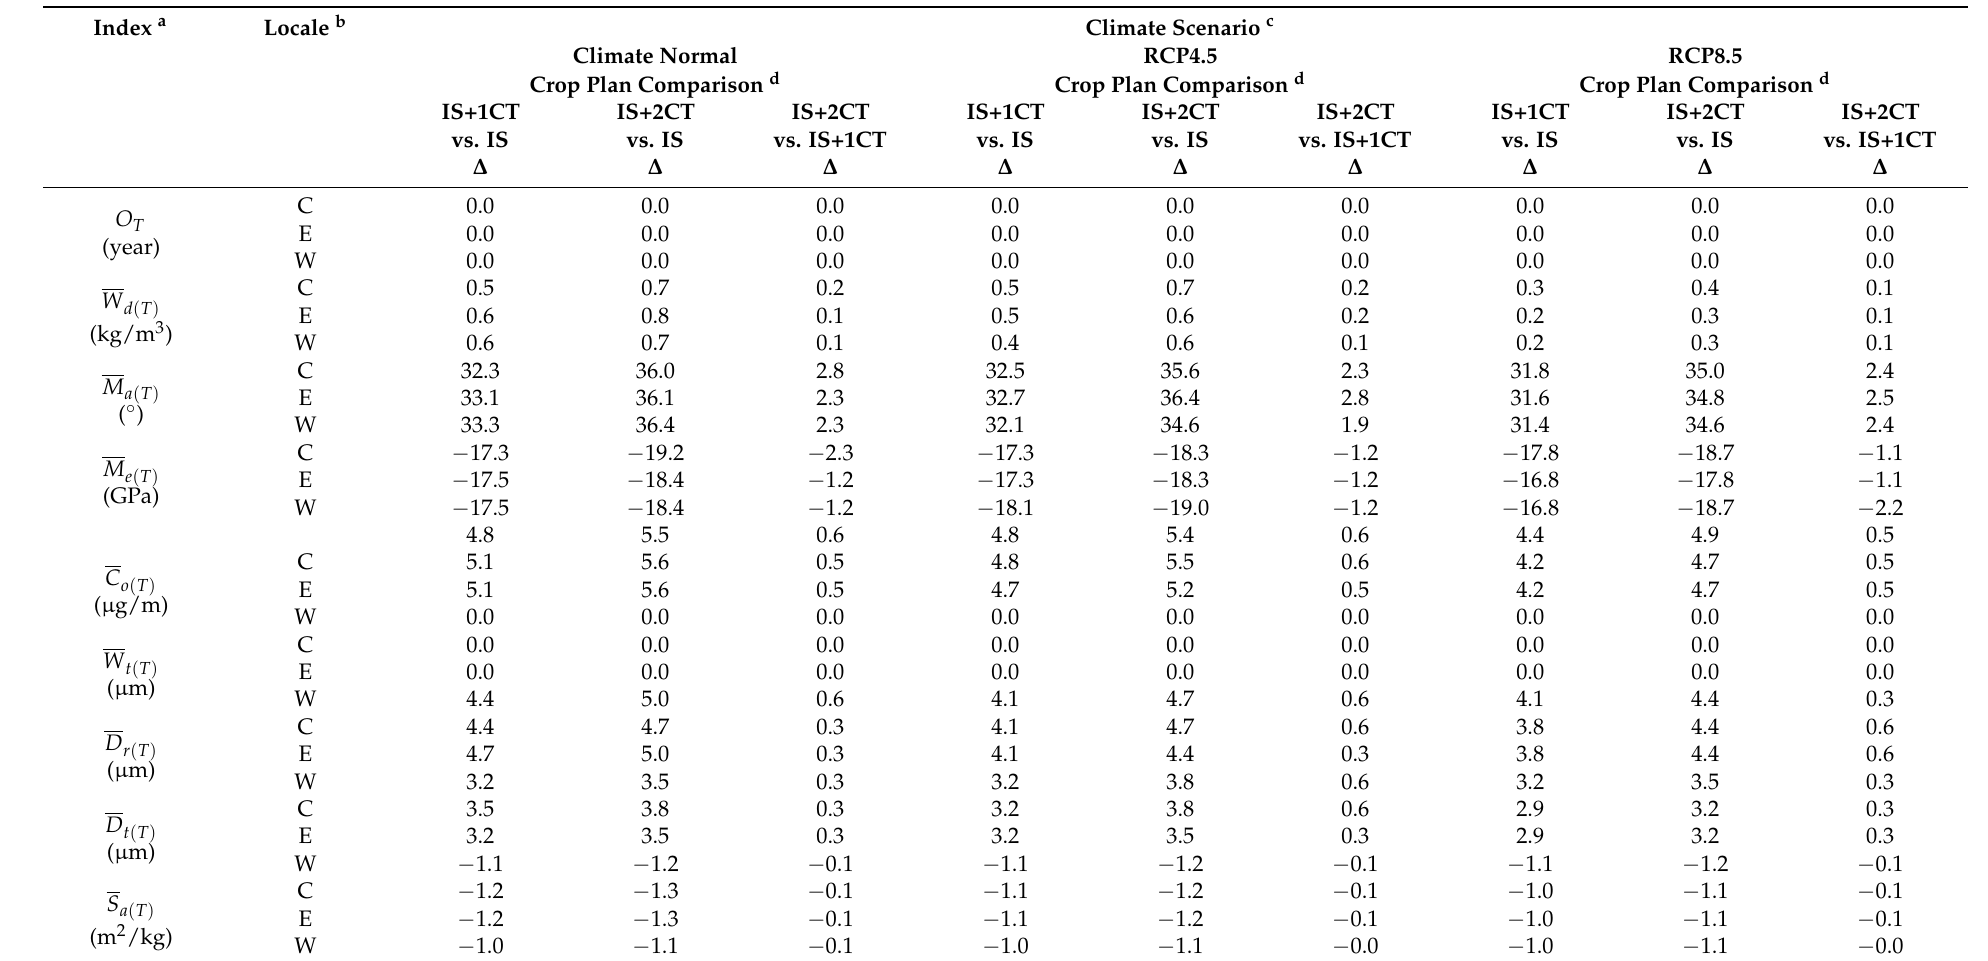
Table 5. b As defined in Table 3. c Crop plan specifics provided in Table 2. d Climate change scenario specifics provided in Table